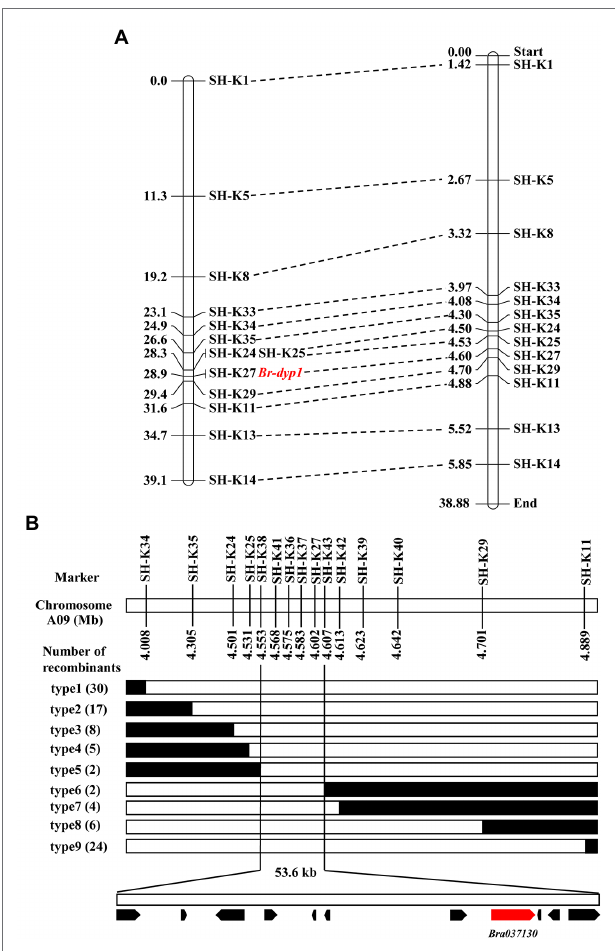
FIGURE 3 | Initial and fine-mapping of the Br-dyp1 gene in Chinese cabbage. (A) Initial mapping of Br-dyp1 . Genetic map of Br-dyp1 is on the left, with cM as the unit. The corresponding physical map (right, unit: Mb) are also shown. (B) Fine-mapping of Br-dyp1 . The Br-dyp1 gene was delimited to an interval between SH-K38 and SH-K43 on chromosome A09, with an estimated physical length of 53.6 kb, and 11 genes were annotated in this region based on the reference genome sequence. The genetic structure of each recombinant type is depicted as white for homozygous dark yellow petal color phenotype, black for heterozygous alleles, respectively. The number of each recombinant type is indicated in the brackets.